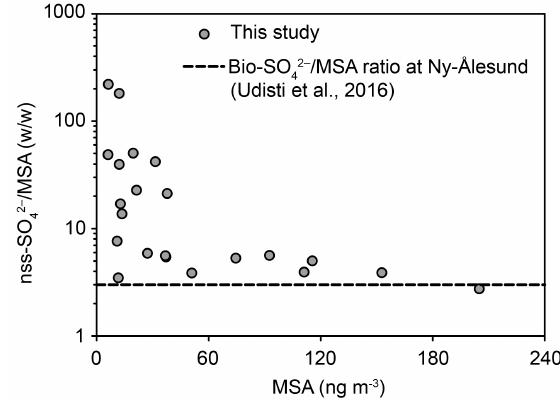
/ MSA ratio and the 4 / MSA ratio measured at Ny- 4